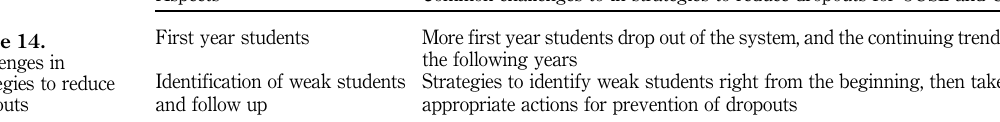
Table 14. Challenges in strategies to reduce